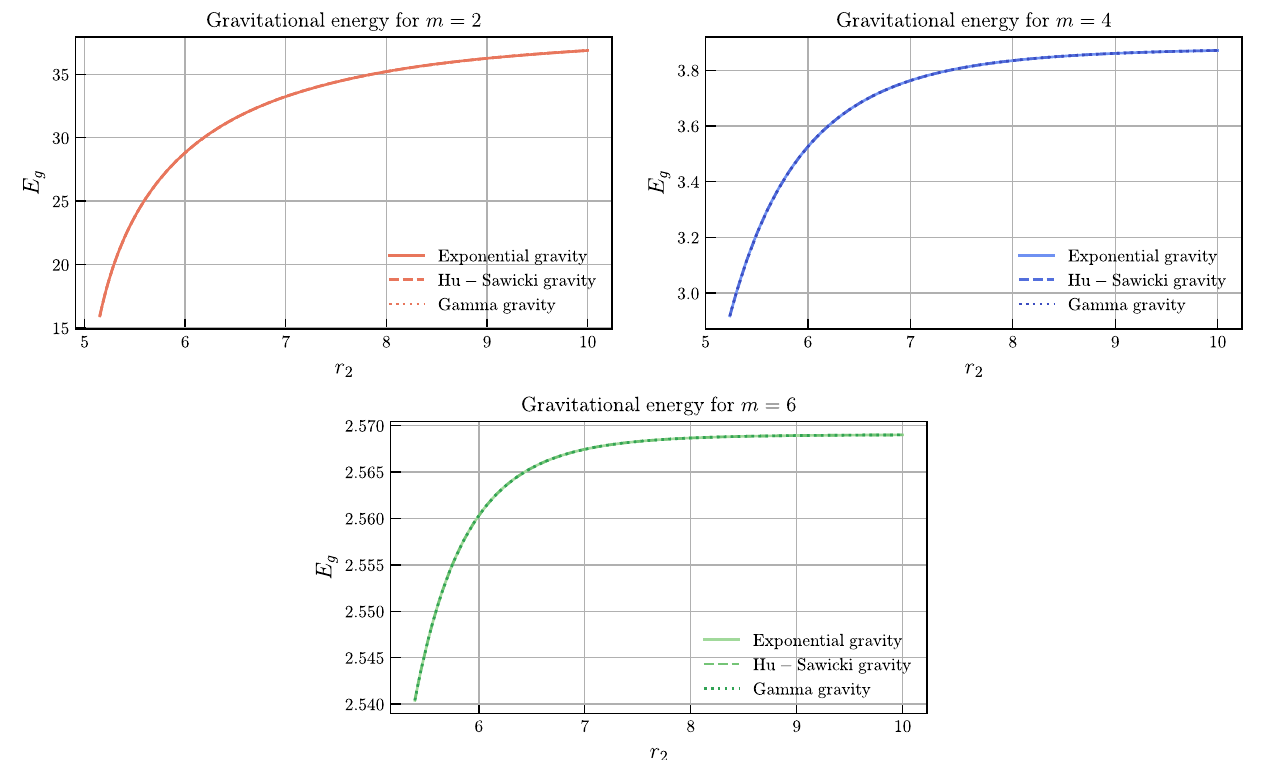
Fig. 8 Total gravitational energy E g for the exponential, Hu–Sawicki and Gamma f ( R ) gravity. As usual, we assume that (cid:17) = 1, α = 0 . 5 and β = 0 .